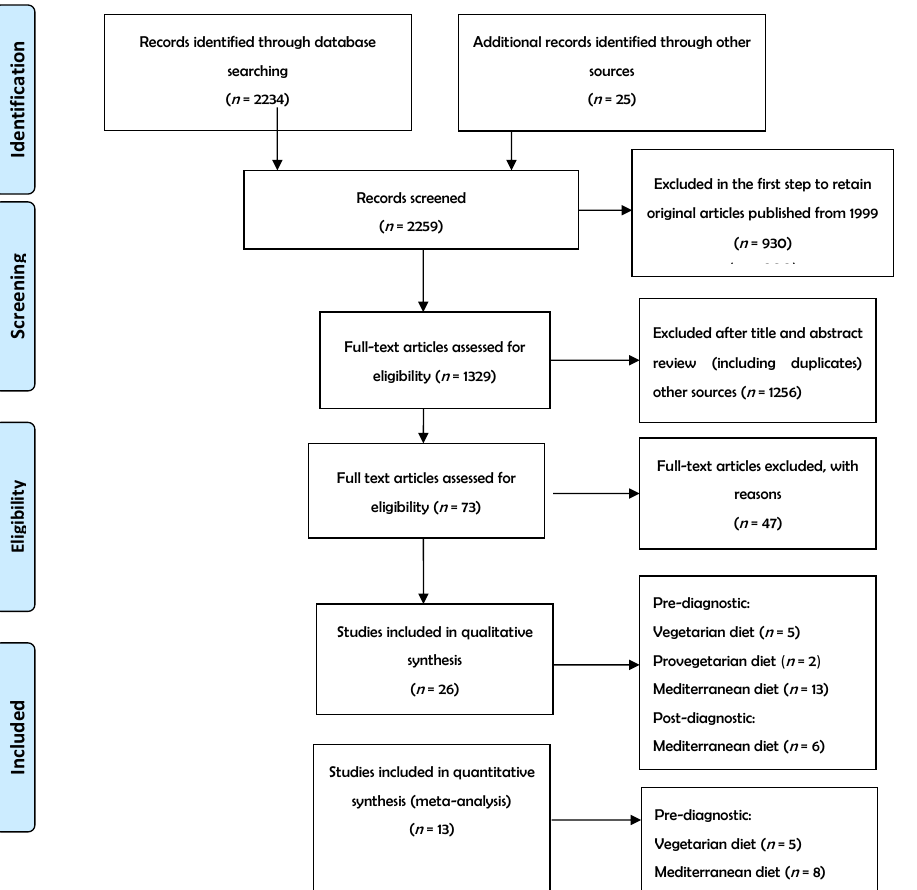
Figure A1. B. Flow diagram illustrating the process of article